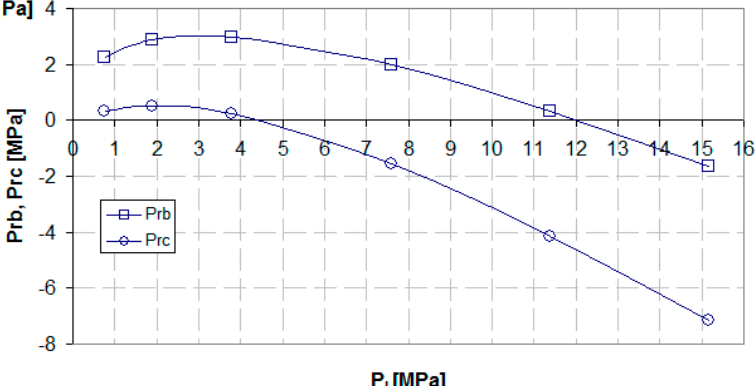
Figure 14. The variability in P rb and P rc as a function of the pressure P L for the coal from the Fruitland 409 Boomer Well B-1 San Juan basin. 410